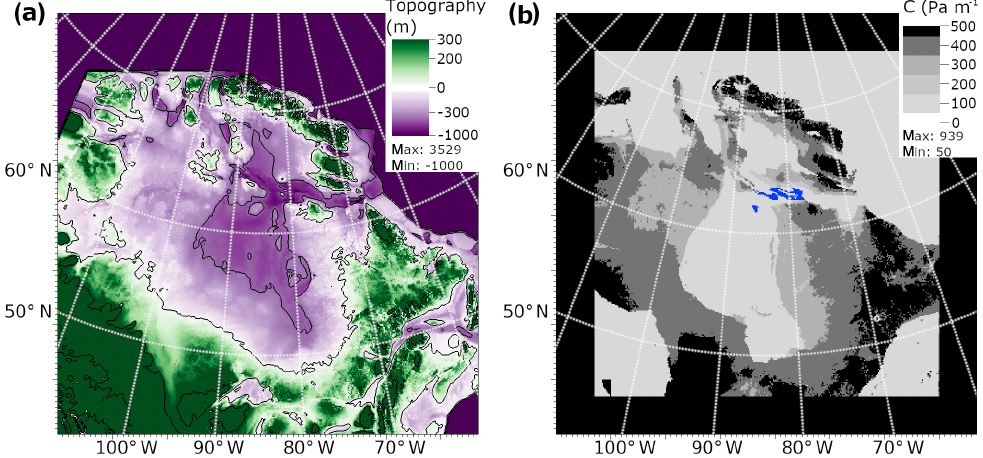
Figure 1. (a) The ETOPO 10ka topography map centred at Hudson Bay on a 10km grid. The basal topography in the northern part of the grid (Greenland and Canadian archipelago) is set to − 1000m to avoid ice sheet formation in these regions. The black lines show contours every 400m. (b) Basal traction coefficient map used in the standard simulation. The basal traction coefficient C values are calculated based on bedrock elevation and sediment coverage. The domain was divided into three different types of sediment coverage: bare bedrock, sediment- covered bedrock and submerged bare bedrock in the Hudson Strait (highlighted in blue, C = 80Pam − 1 a). The outermost 35 grid cells along both axes are initialised with a high basal traction coefficient ( C = 450Pam − 1 a) to avoid ice flow reaching the edges of the